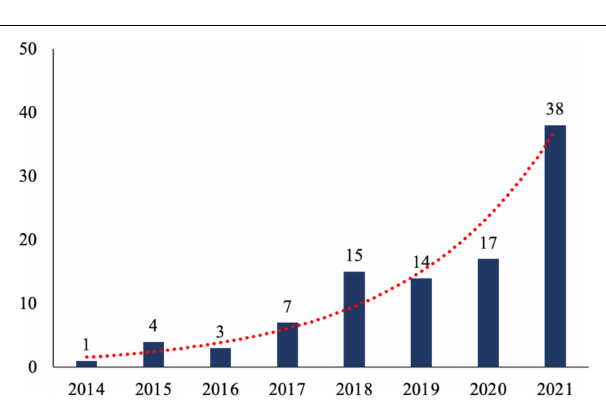
FIGURE 2 | Publication